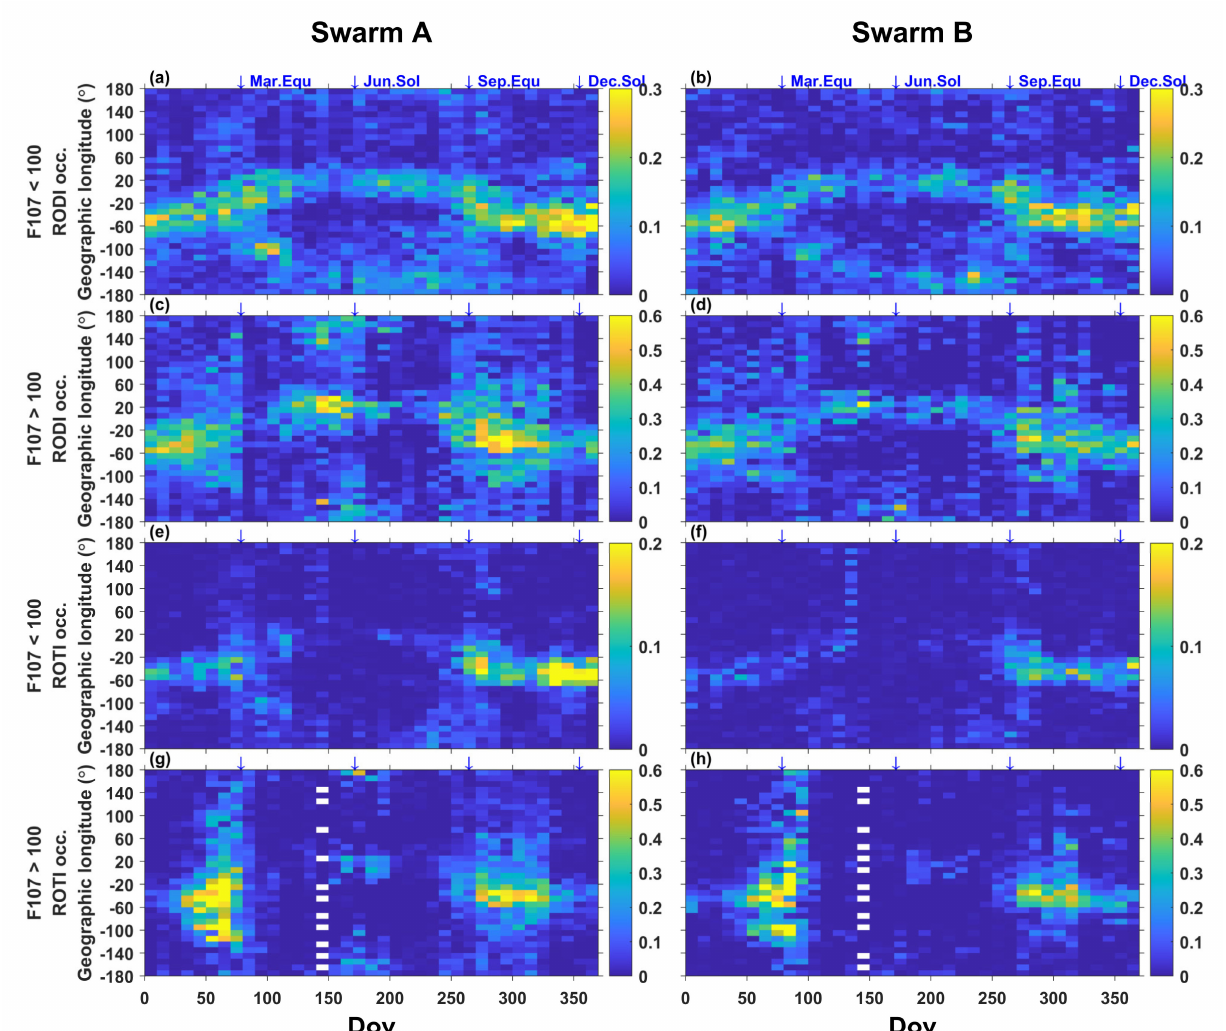
Figure 9. Variations of the plasma irregularity occurrence rate as a function of Doy and longitudes. The equinoxes and solstices are indicated by the arrows on the top of each panel. The panels from top to bottom show results for RODI occurrence (F107 < 100, ( a – b )), RODI occurrence (F107 > 100, ( c – d )), ROTI occurrence (F107 < 100, ( e – f )), and ROTI occurrence (F107 > 100, ( g – h )), from left to right show results for Swarm A and Swarm